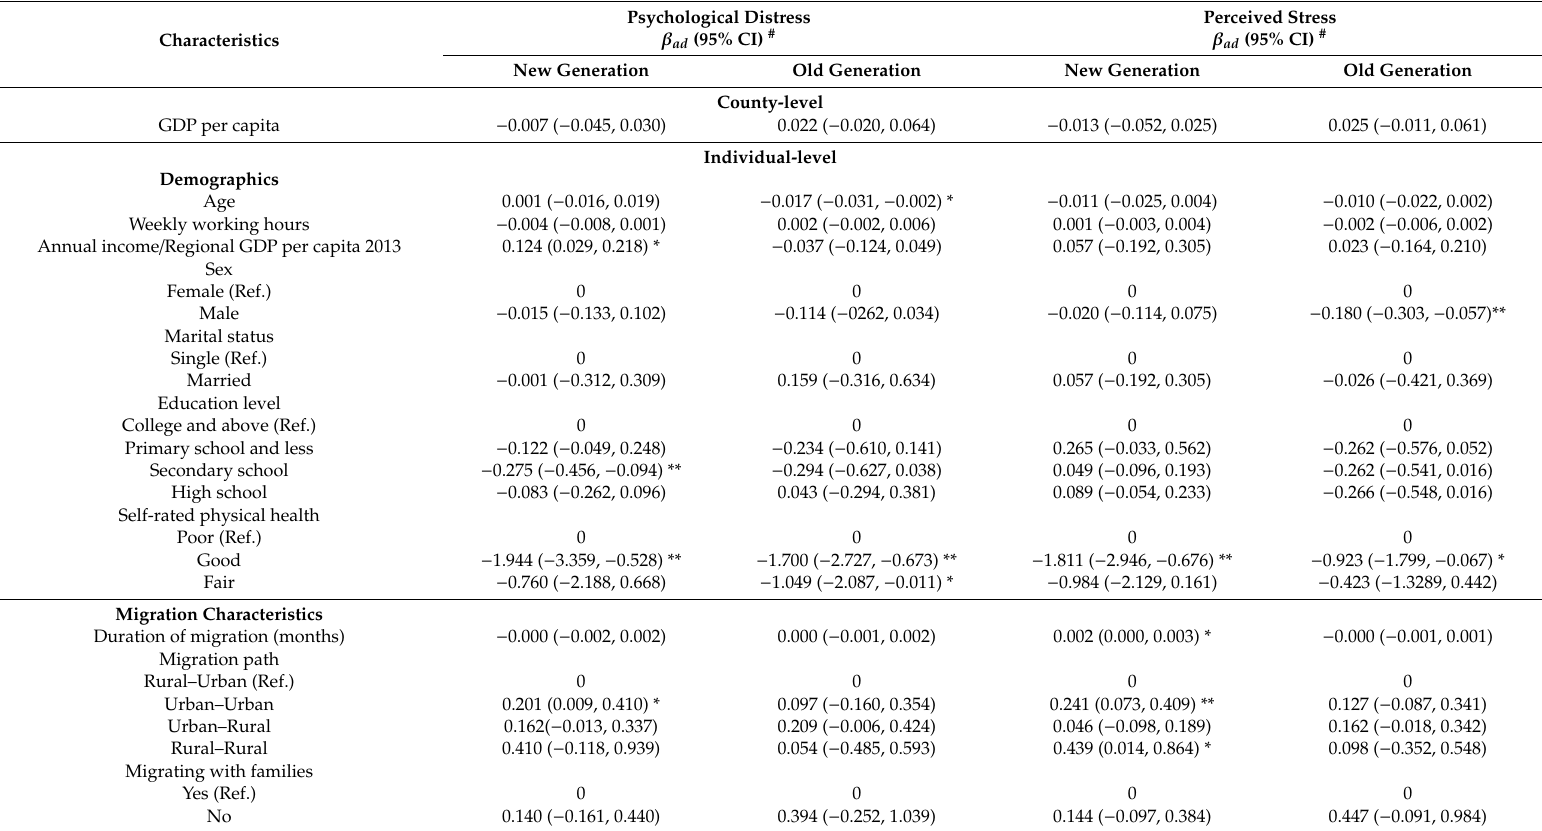
Table 3. Correlative factors of mental health of new- and old-generation internal migrants,